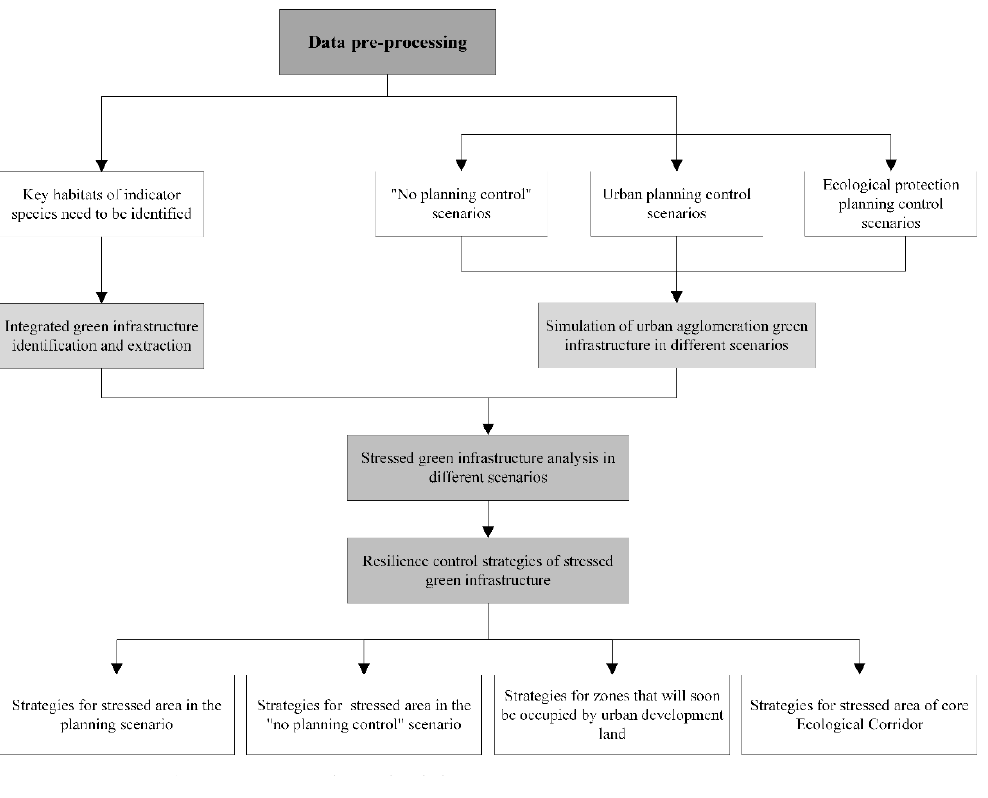
Figure 2. Research methodology.